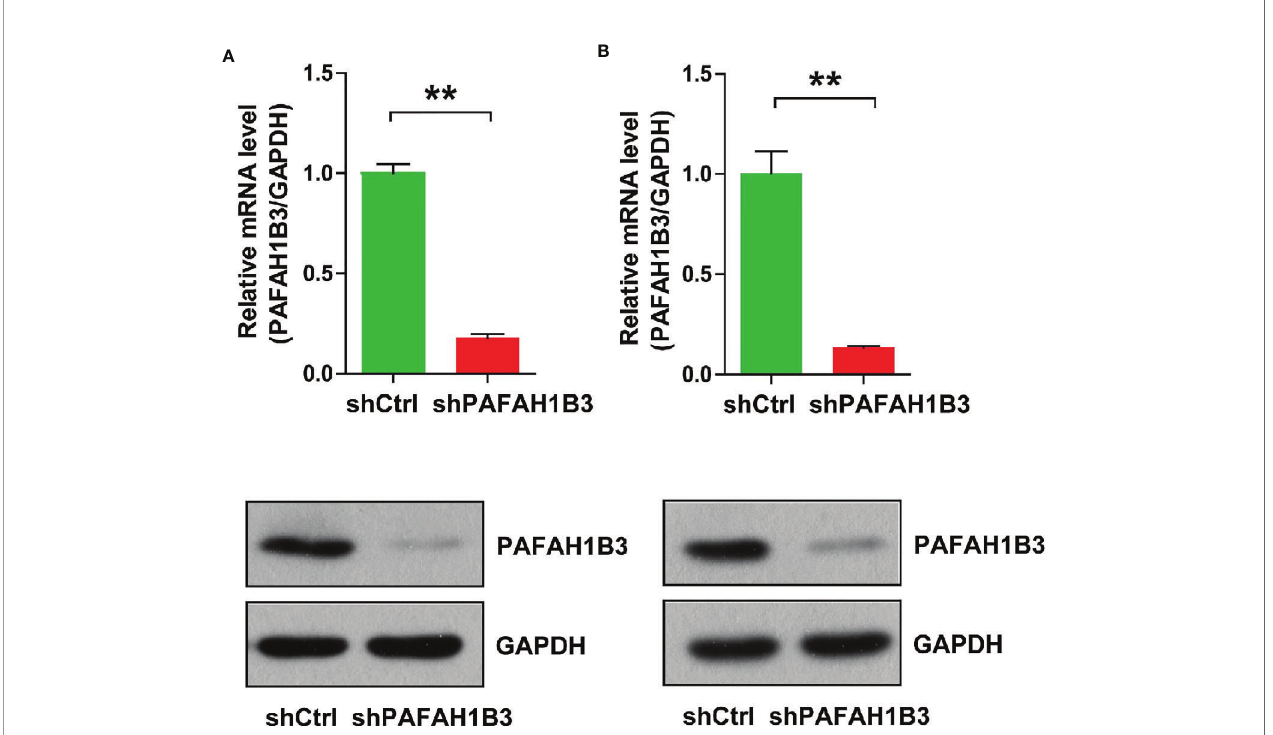
FIGURE 2 | (A) The knockdown ef fi ciency of PAFAH1B3 by infection of lentivirus-mediated siRNA and the negative control siRNA in MNNG/HOS cells was veri fi ed by qRT-PCR and Western blot. Data were expressed as the mean ± s.d., ** P < 0.01. (B) The knockdown ef fi ciency of PAFAH1B3 by infection of lentivirus-mediated siRNA and the negative control siRNA in U-2 OS cells was veri fi ed by qRT-PCR and Western blot. Data were expressed as the mean ± s.d., ** P <